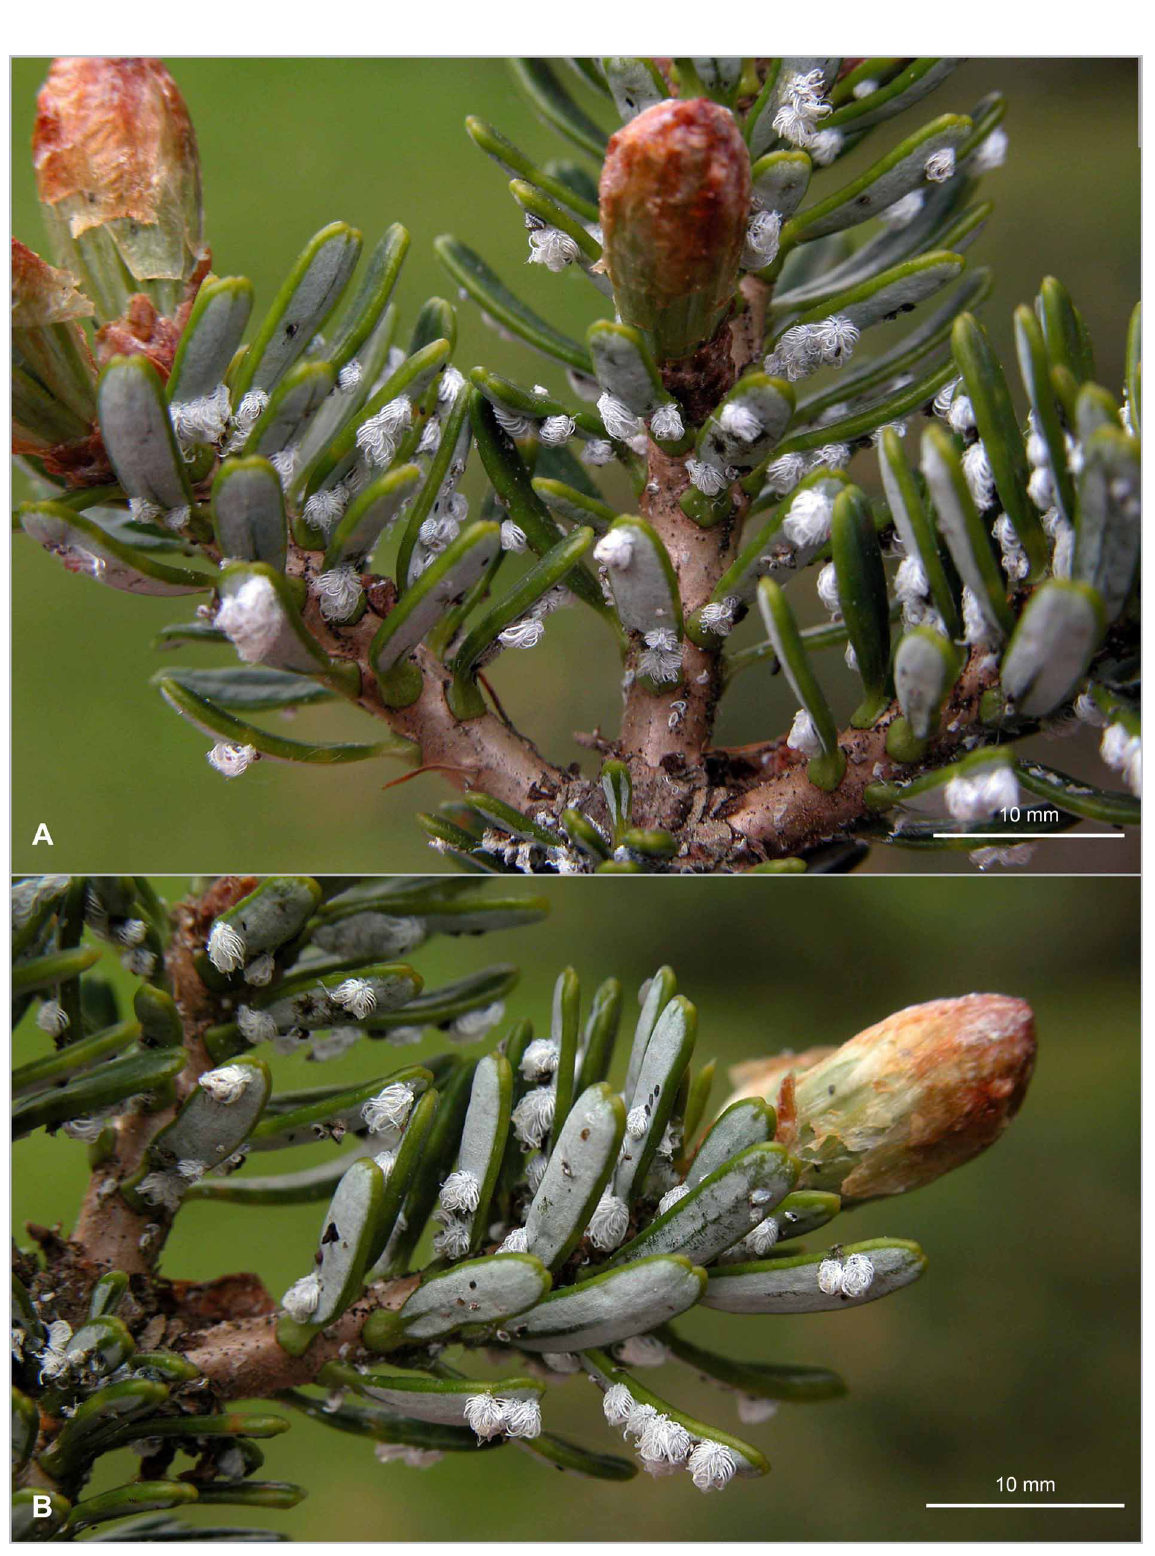
Fig. 41. Adelges (Aphrastasia) pectinatae (Cholodkovsky, 1888). Apterous progredientes on undersides of needles of Abies koreana . Note the conspicuous coarse wax